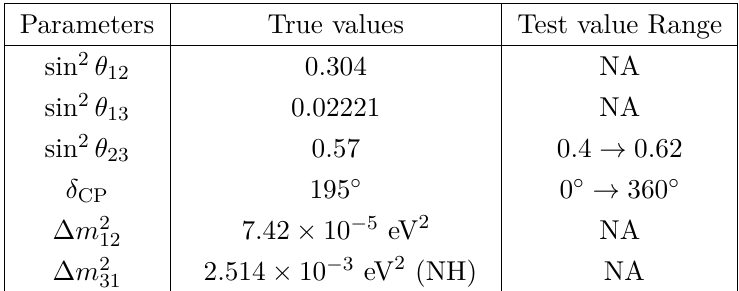
as mentioned in the above 23